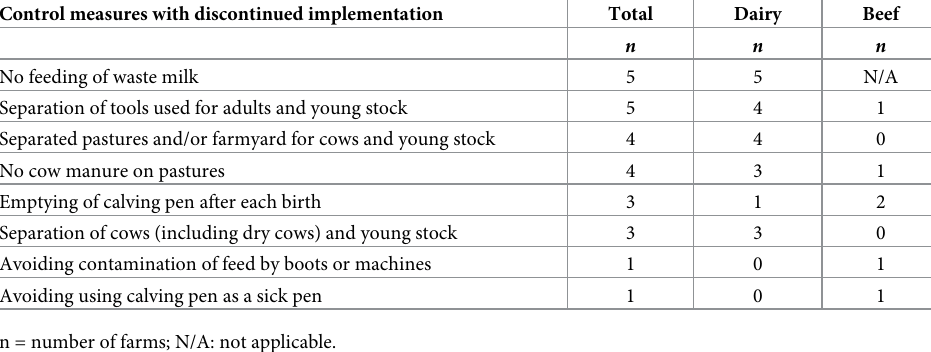
Table 5. Number of farms where the implementation of control measures to reduce the spread of paratuberculo- sis was partially or completely discontinued in the course of the three-year period of observation. Control measures with discontinued implementation Total Dairy Beef n n n No feeding of waste milk 5 5 N/A Separation of tools used for adults and young stock 5 4 1 Separated pastures and/or farmyard for cows and young stock 4 4 0 No cow manure on pastures 4 3 1 Emptying of calving pen after each birth 3 1 2 Separation of cows (including dry cows) and young stock 3 3 0 Avoiding contamination of feed by boots or machines 1 0 1 Avoiding using calving pen as a sick pen 1 0 1 n = number of farms; N/A: not